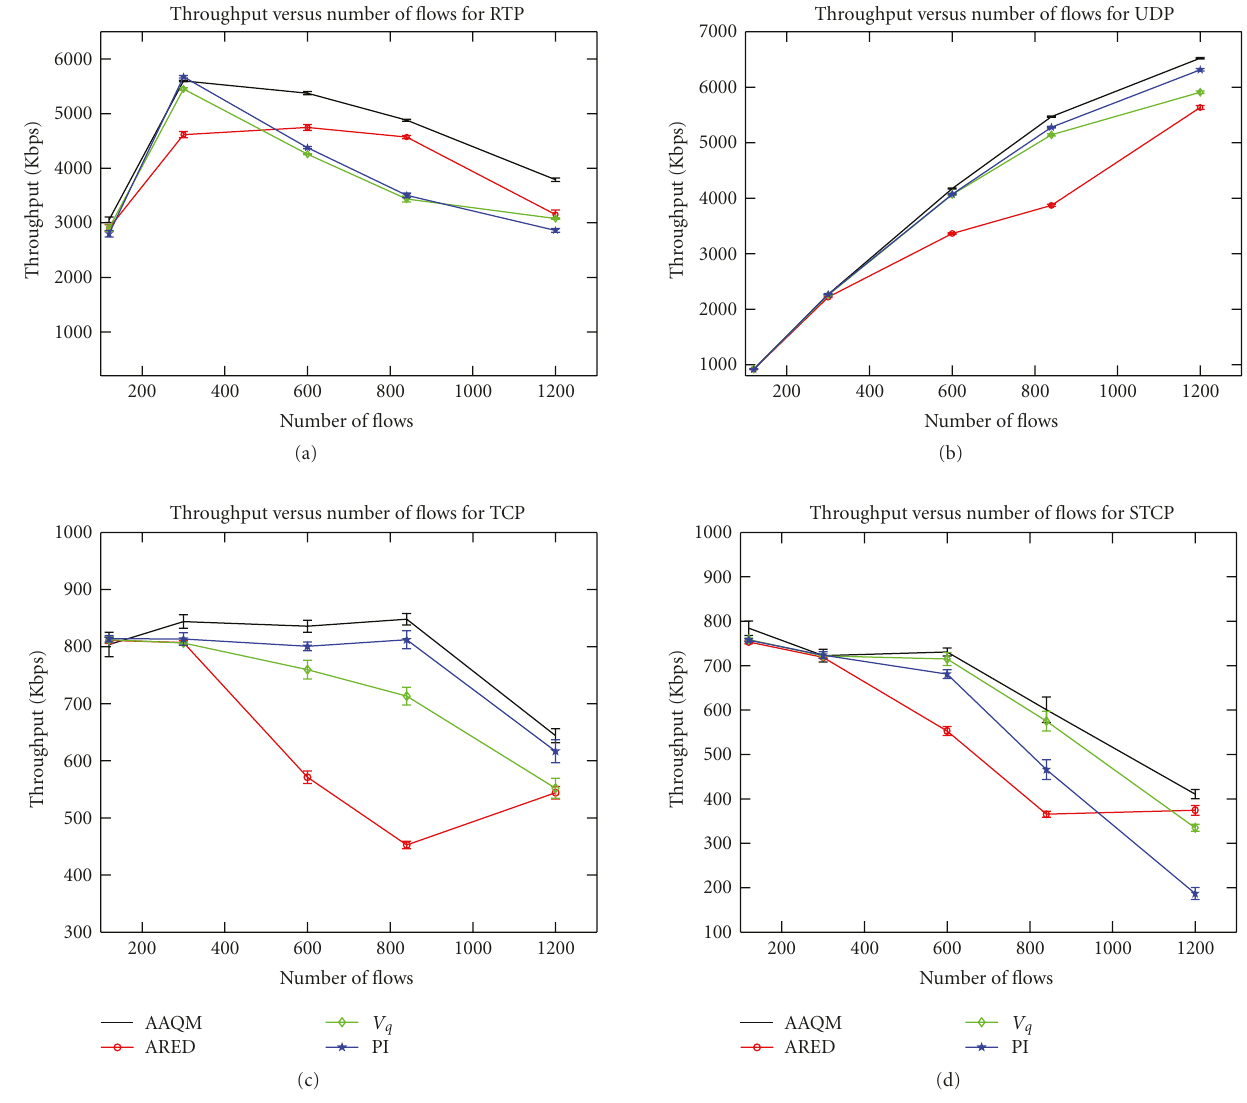
Figure 11: Throughput for (a) Video Tra ffi c, (b) Multimedia Tra ffi c, (c) TCP Tra ffi c (long-lived), and (d) SCTP tra ffi c.